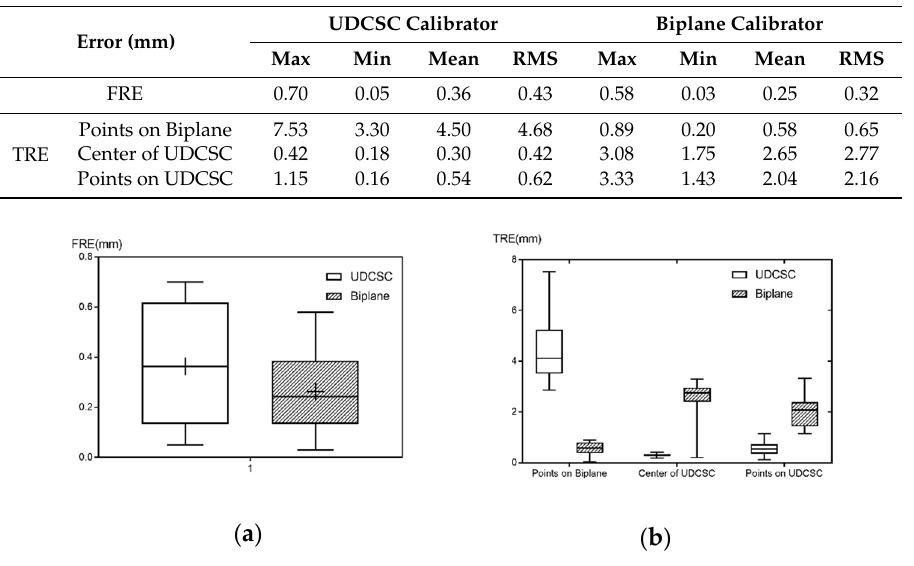
Figure 14. The errors of targets on calibrator. Table 1. Comparison of calibration accuracy of different calibrators.